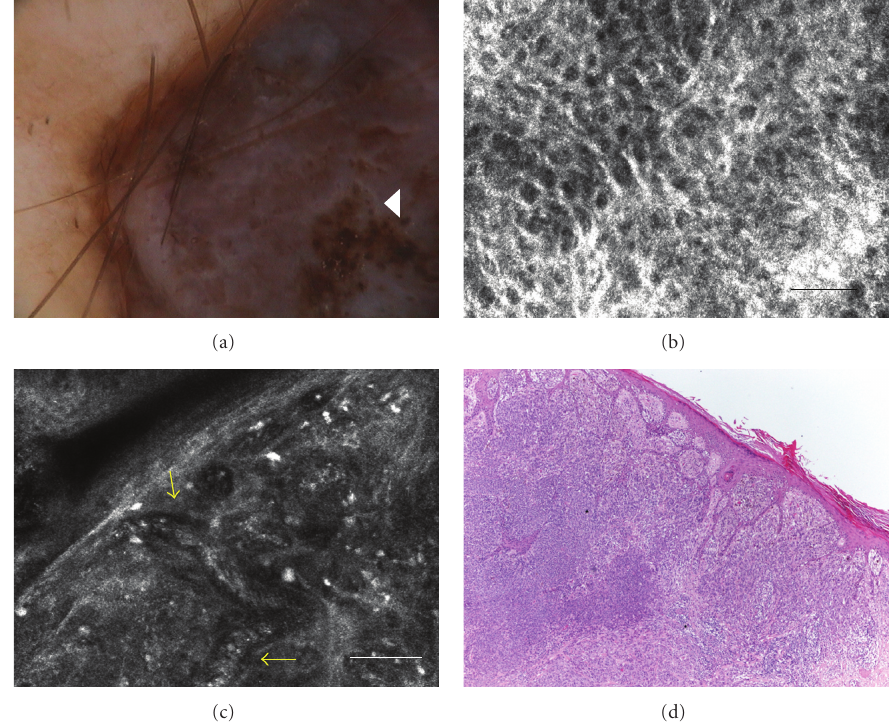
Figure 3: (a) Dermoscopic image of nodular pigmented lesion with an atypical globular pattern, structureless dark brown areas, irregular brown dots in the center of the lesion ( white arrowhead ), and a blue-white veil (original magnification 50 × ). (b) RCM image (0 . 5 × 0 . 5 mm) acquired at stratum granulosum-spinosum, showing broadened honeycombed (scale bar: 50 µ m). (c) RCM image (0 . 5 × 0 . 5 mm), at dermal level, showing markedly pleomorphic cells distributed in sheet-like structures in the dermis and numerous bright dots. Inside the tumoral nested proliferation, new-born vessels are present ( yellow arrows ) (scale bar: 50 µ m). (d) Histological image showing an overview of the nodular melanoma with Breslow thickness of 6.5 mm (H&E section; original magnification ×